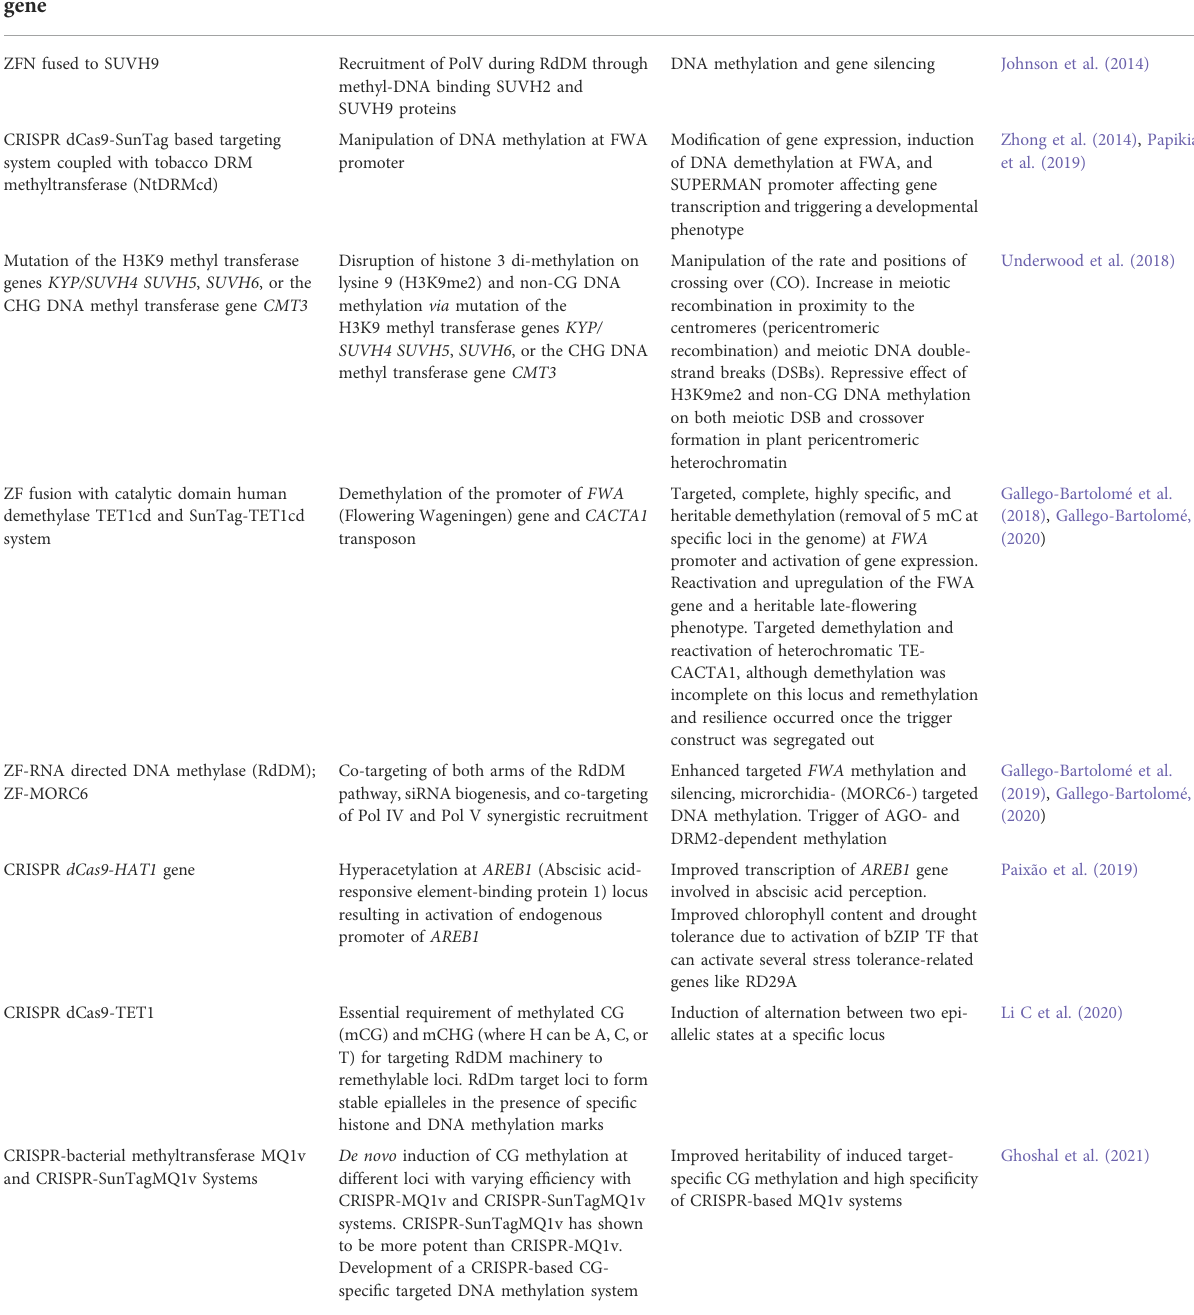
TABLE 3 Epigenome editing in the model plant Arabidopsis thaliana